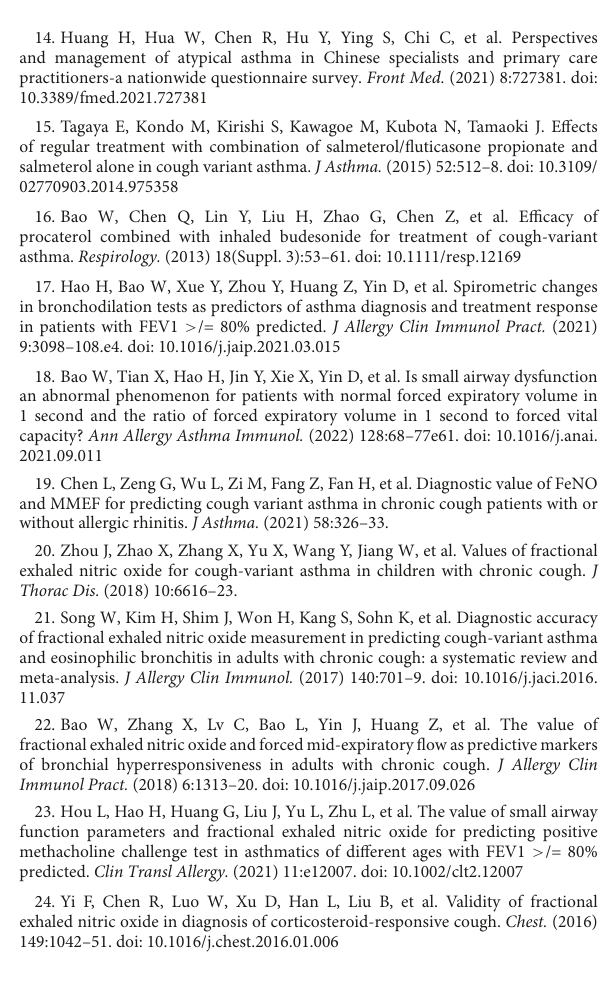
SUPPLEMENTARYFIGURE2 The improvement of FEV 1 from baseline to 4 weeks of anti-asthma treatment in different layers of FEV 1 %pred. FEV 1 %pred, percentage of predicted forced expiratory in 1